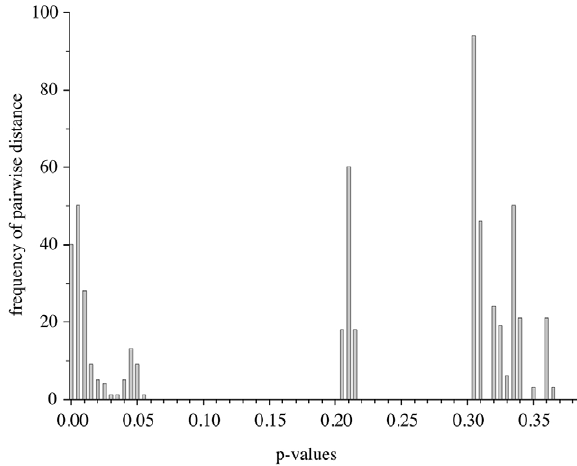
Fig. 2. – Frequency spectrum of pairwise genetic distances (p-dis- tance) of 16S rRNA gene among specimens of the cumacean genus Leucon Krøyer, 1846. Distances on the right side of the graph dis- play interspecific variation, distances on the left display intraspe- cific variation. Distances in the middle display variation between L. antarcticus Zimmer, 1907 and L. rossi Rehm and Heard, 2008.